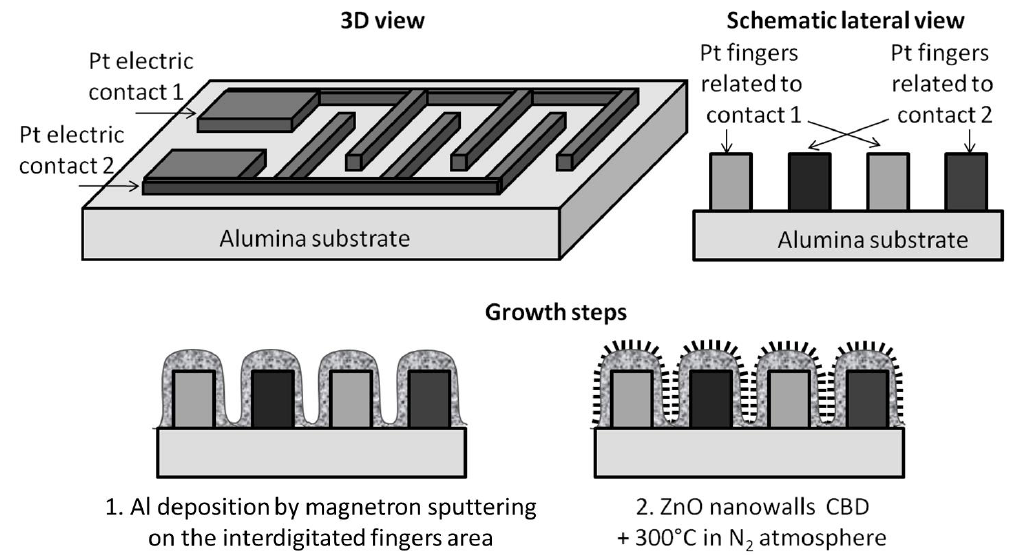
Figure 1. Schematization of the various steps for the preparation of the ZnO nanowalls-based conductometric sensor.